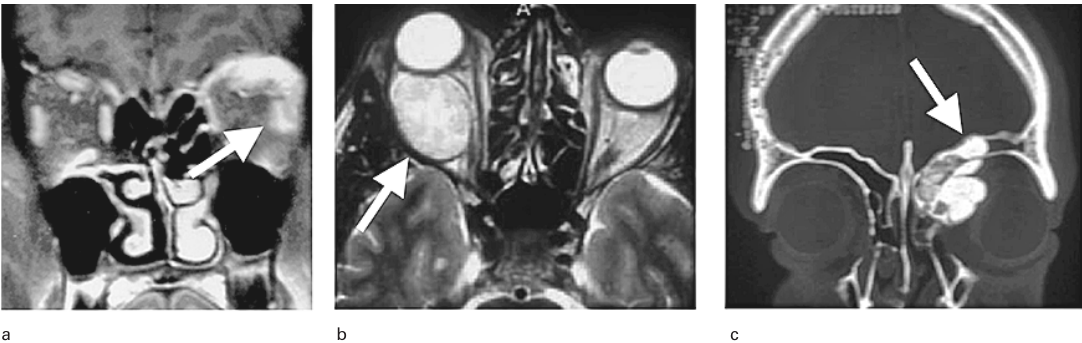
Examples of differential diagnoses mimicking unilateral Graves’ orbitopathy. a) Coronal fat saturation, post contrastT1-w images. Orbital myositis with increased thickness of the left lateral rectus muscle with dense contrast enhancement, combined with a soft tissue mass in the superlateral extraconal space (arrow). b) AxialT2-w sequence. Intraconal haemangioma of the right orbit (arrow).